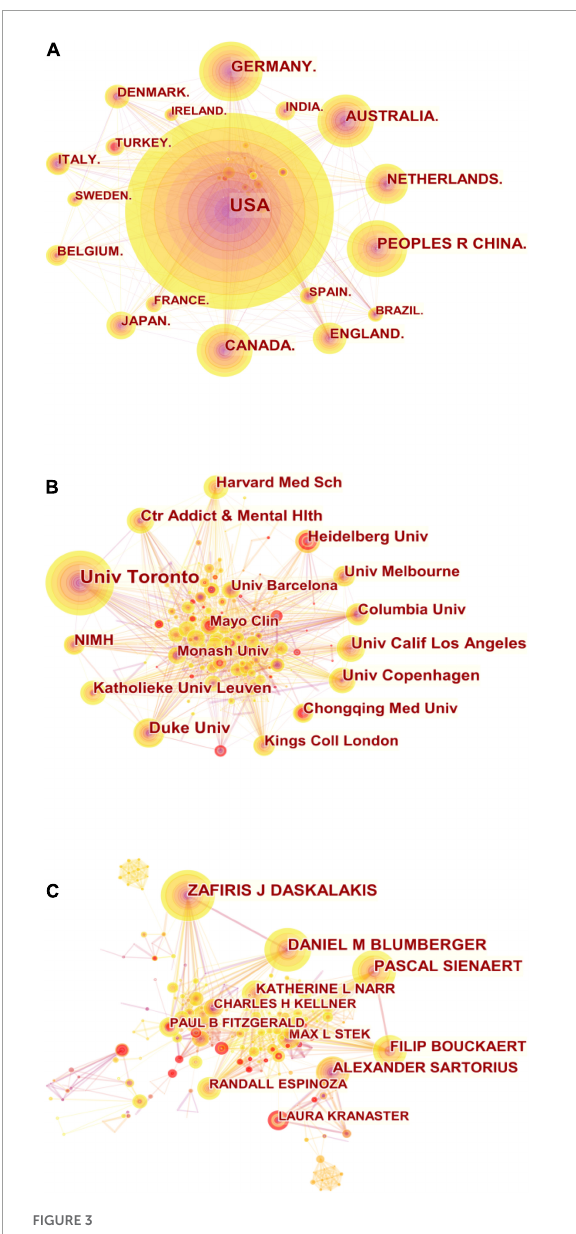
FIGURE3 (A) Collaboration among countries/regions. (B) Collaboration among institutions. (C) Collaboration among